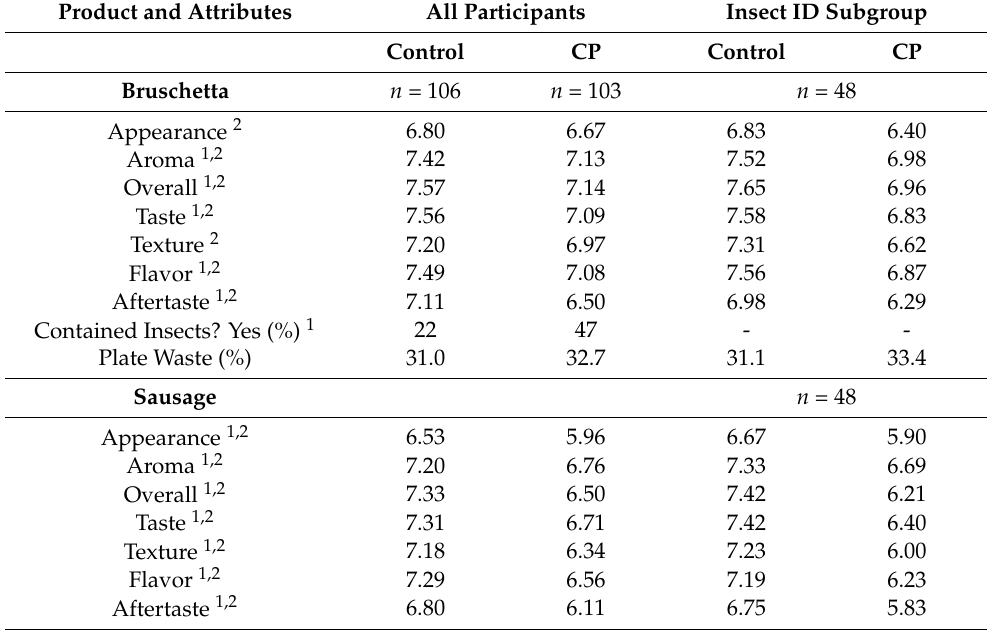
Table 3. Mean attribute liking scores, percentage of participants who selected “Yes” the dish contained insects, and plate waste for the dishes/products evaluated (bruschetta, sausage, pasta, and brownies) for all participants and the Insect ID subgroup. Base sizes ( n ) of participants that evaluated each product/dish are also shown. Parameters colored (blue for ALL participants, yellow for the Insect ID subgroup) and denoted were found to be significantly different ( p < 0.05) using a two-way ANOVA, blocked on Treatment and Participants, for hedonic liking and plate waste. A two-tailed z -test was used for the “Yes, it contained insects”